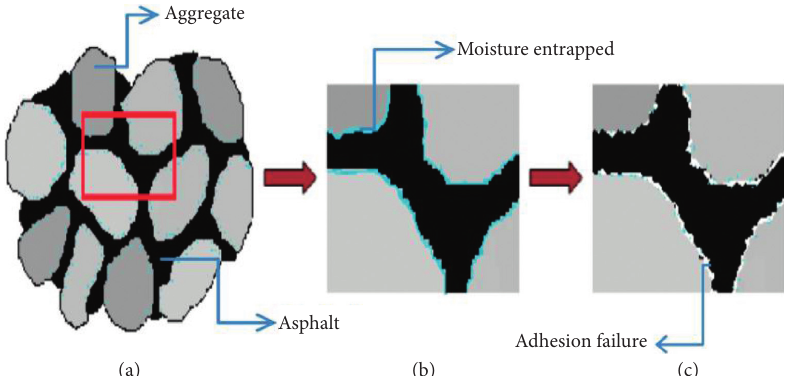
Figure 1: Moisture damage in warm mix asphalt holding moist aggregates (adopted from [16]) (a) Asphalt mixture. (b) Binder aggregate interface. (c) Damaged